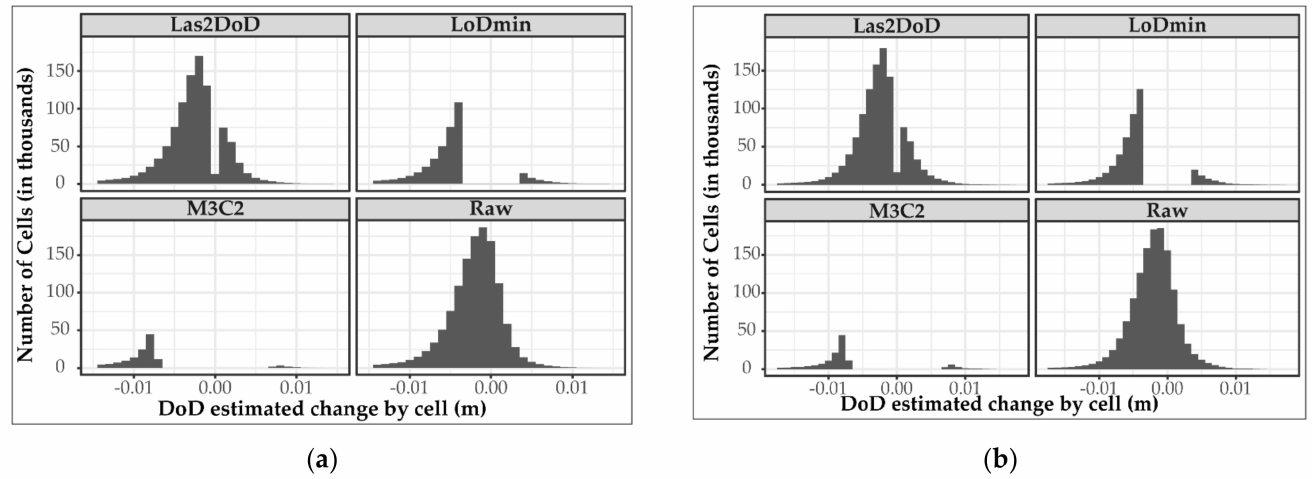
Figure 7. Histograms from the final DoD of the selected uncertainty analysis methods and a raw DoD without uncertainty analysis for Plot A ( a ) and Plot B ( b